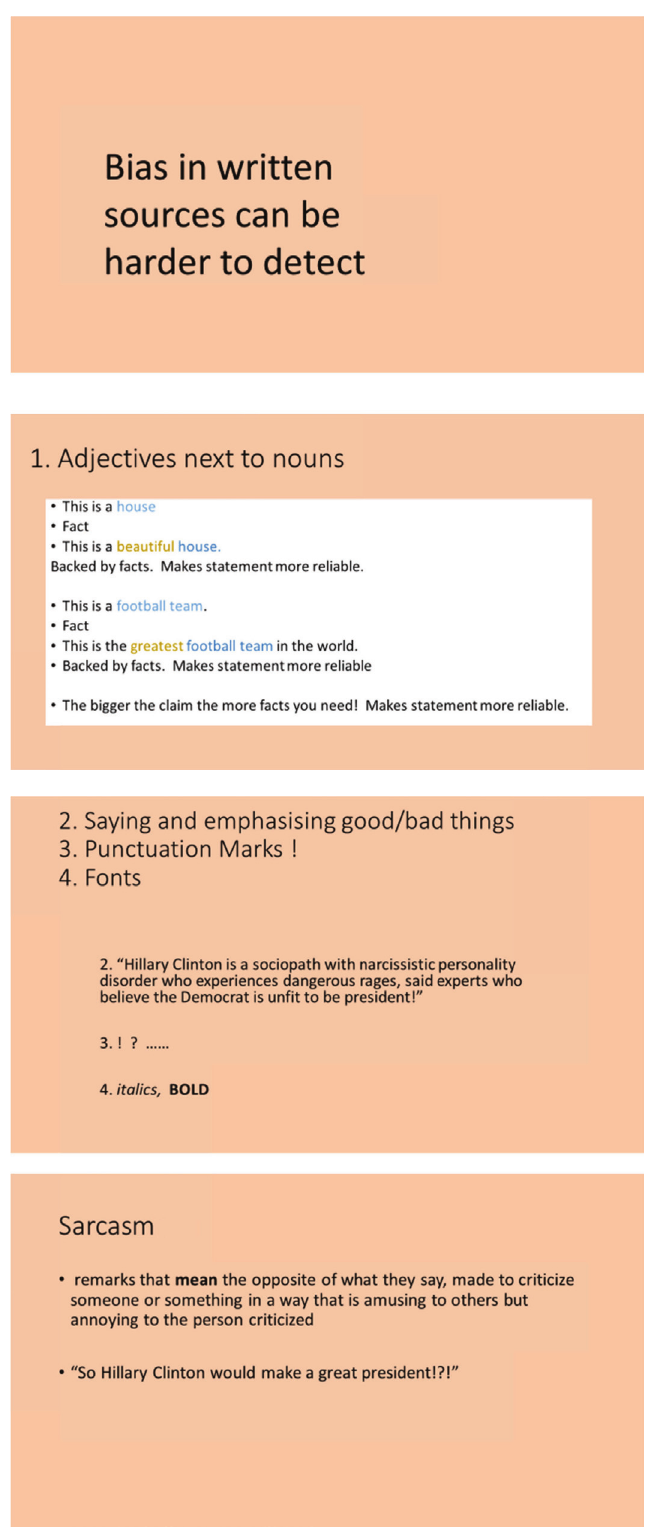
Figure 5: Set of cards used by researcher during class discussion on ‘what is bias?’ Source : Vella (2008: